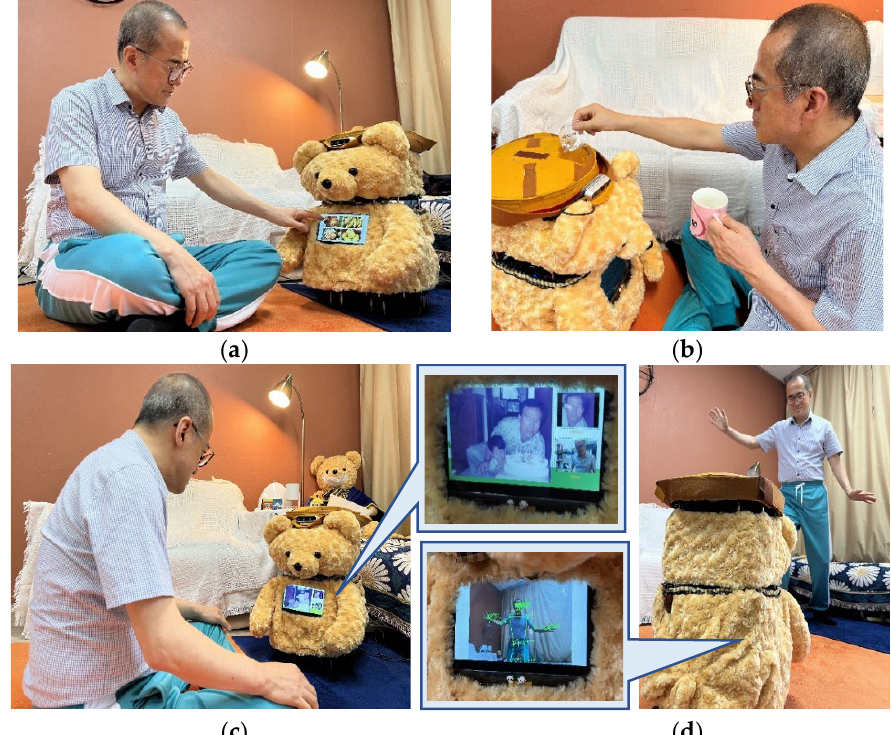
Figure 1. Scenes illustrating care robot services: ( a ) cognitive activity in which the user chooses a food item and then calculates the price of the food; ( b ) medication instruction and distribution of medication at a specific time; ( c ) emotional activity involving talking about childhood photos; ( d ) game involving use of body movement.